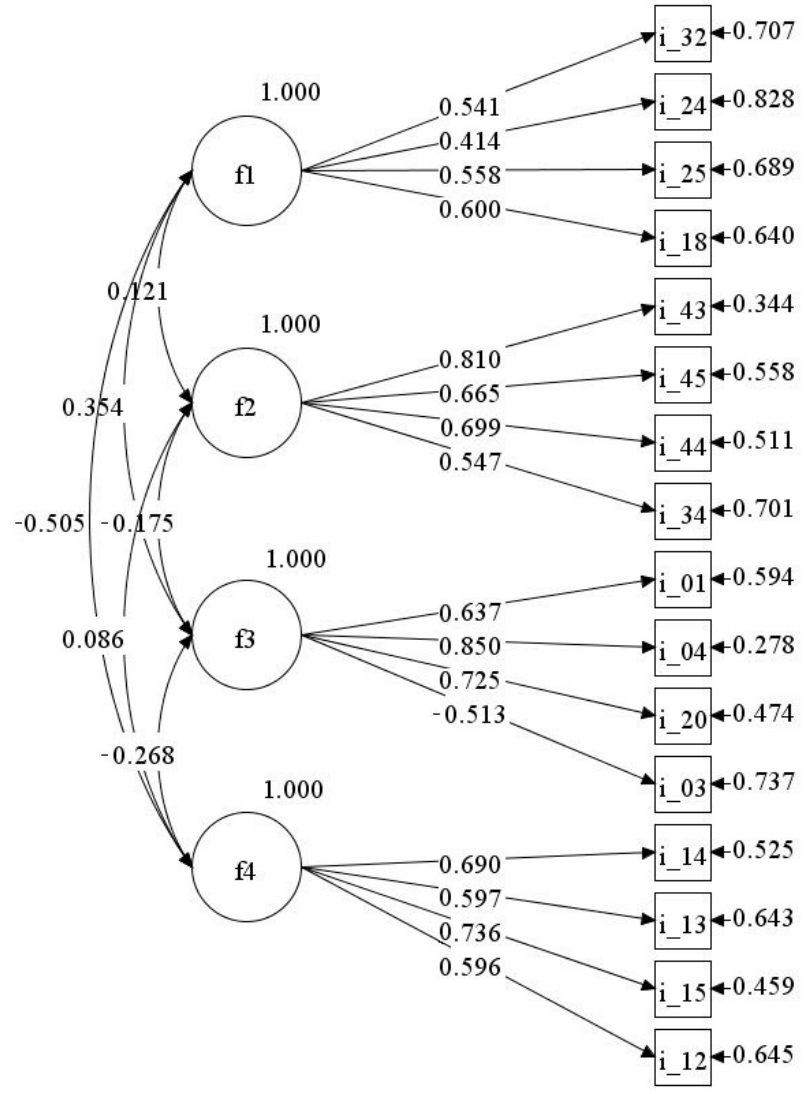
Figure 2. CFA of the Family, Peers, and Externalising Behaviour (FPEB) scale; N = 388. Items i_3, i_12, i_13, i_14, i_15, i_34, i_43, i_44, i_45 are reverse items. f1 = “Externalising behaviour”, f2 = “Peer relations difficulties”, f3 = “Family conflict”, f4 = “Lack of family